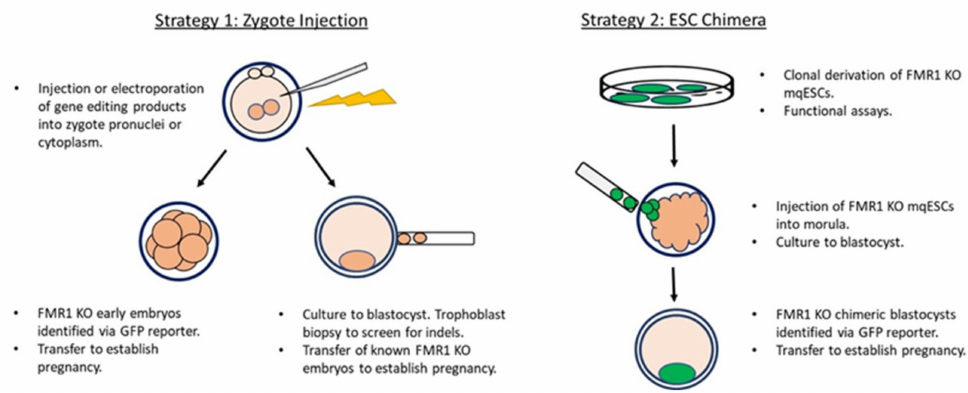
Figure 1. Strategies for modeling Fragile X syndrome in the nonhuman